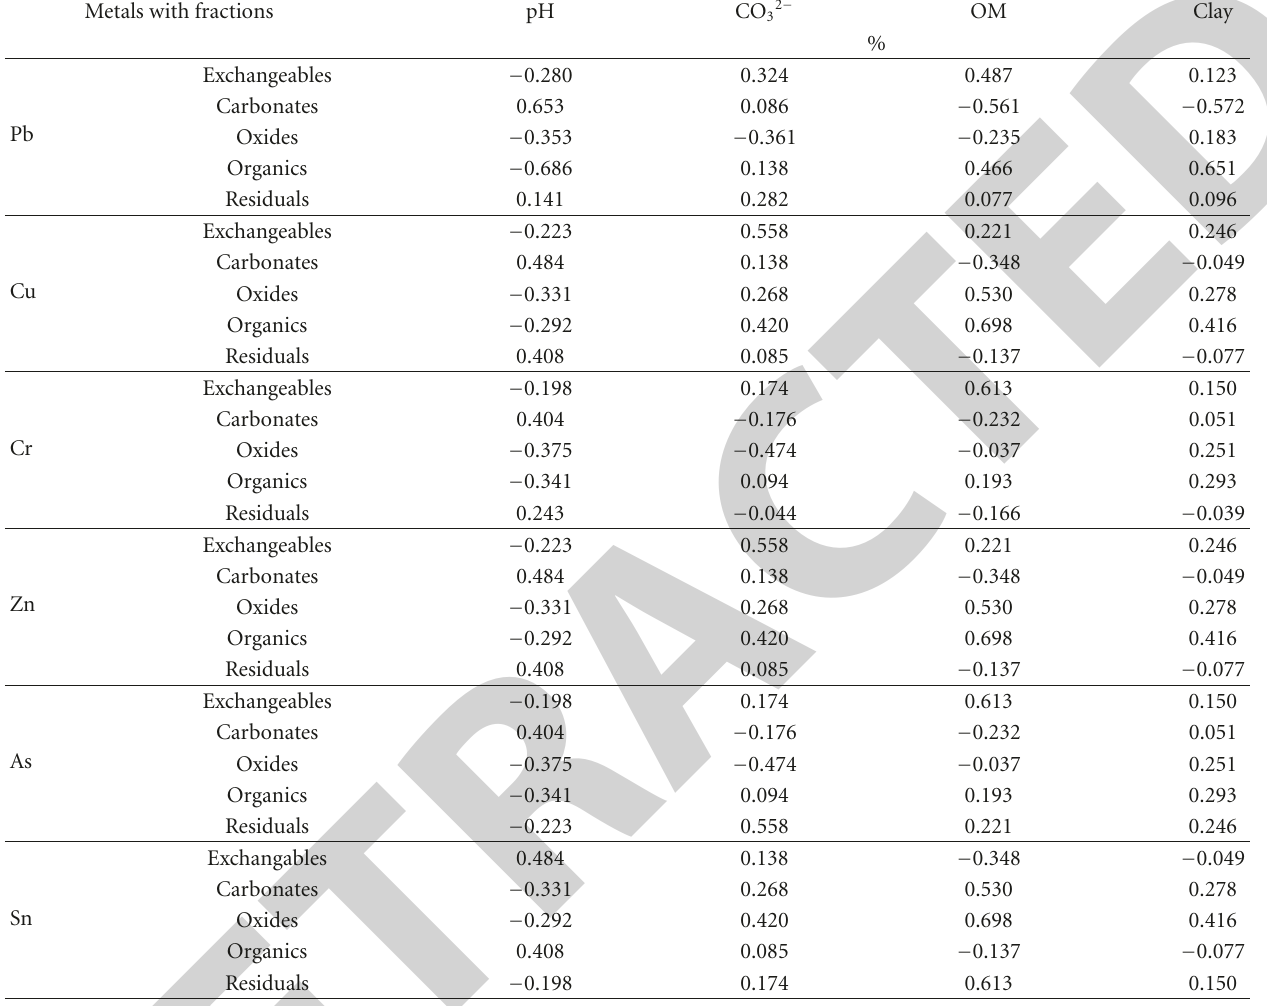
Table 4: Correlation between pH, Carbonates, organic matter content, and clay percentages with contents of heavy metals (mg/kg). Metals with